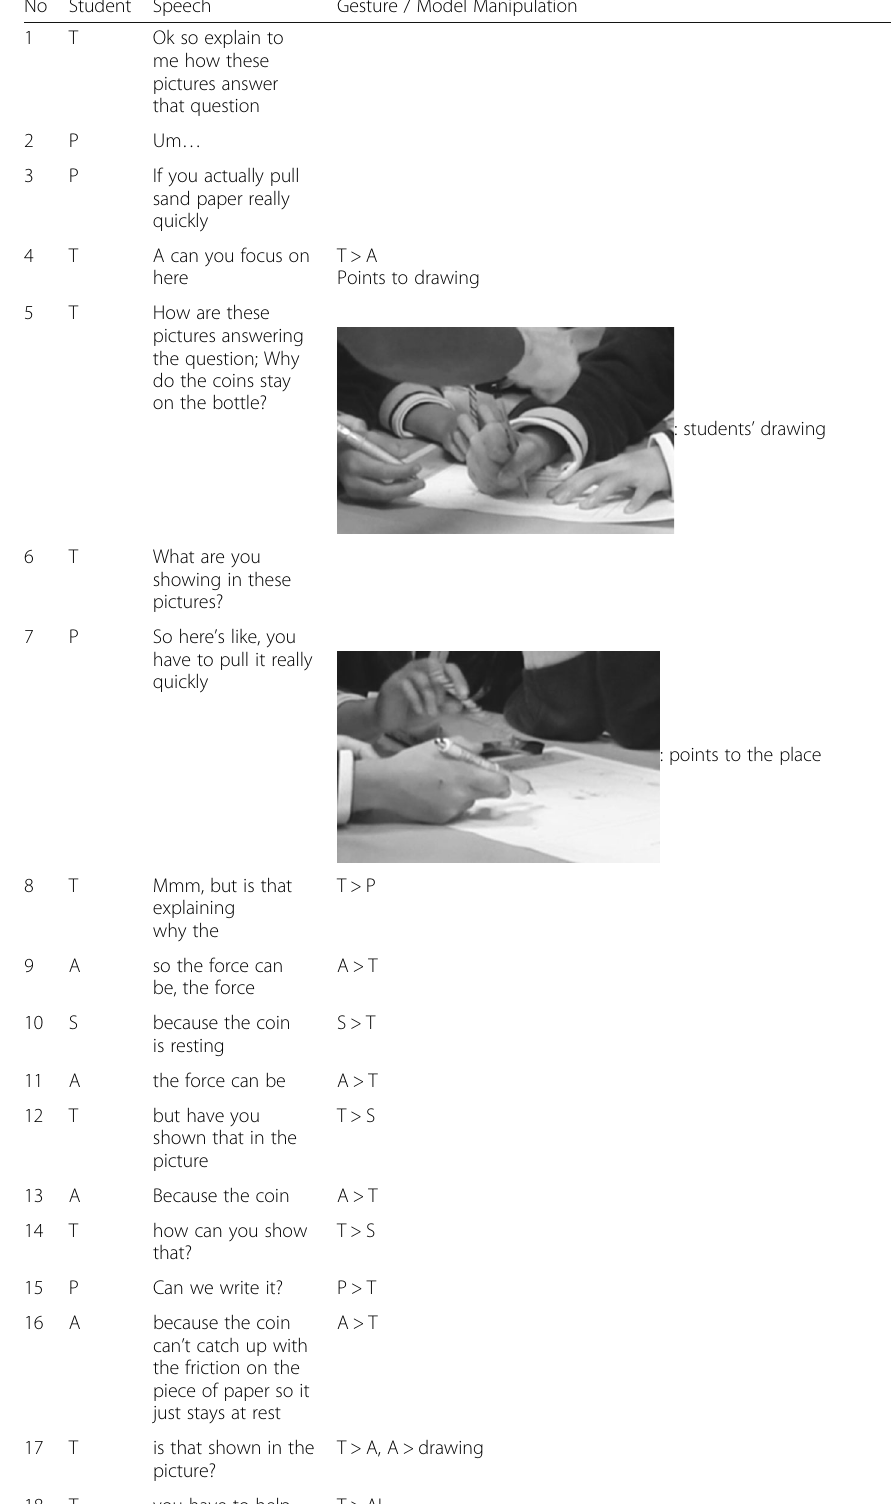
Table 5 Group 2 Co-Constructing the